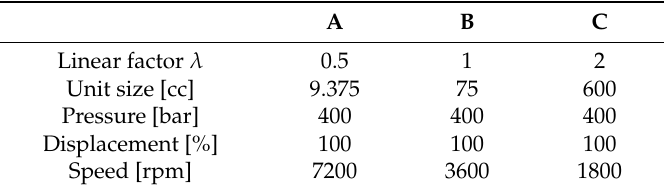
Figure 5. Solid body mesh and thermal boundaries. Table 1. Summary of unit sizes and operating